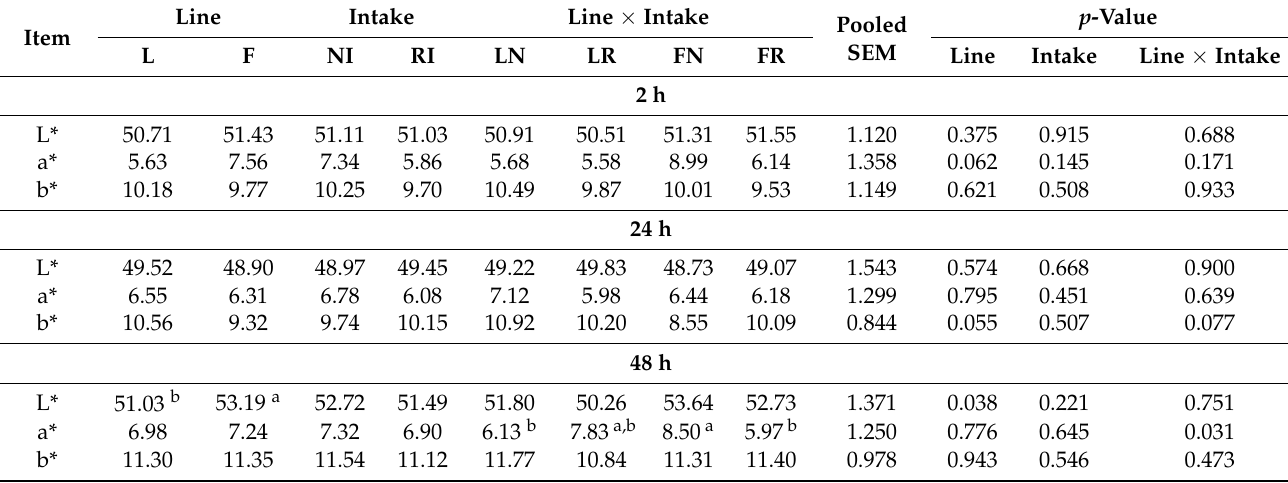
Table 3. Effect of feed intake on thigh muscle color of 56-day-old offspring in broiler hens during laying period (n =